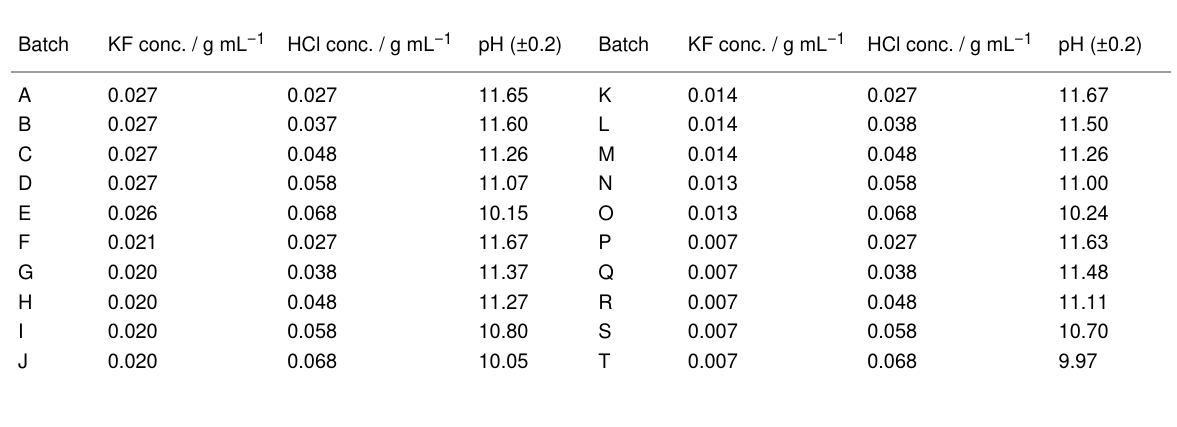
Table 5: Concentration of KF and HCl and the resulting pH values used for different batches (from A to T).